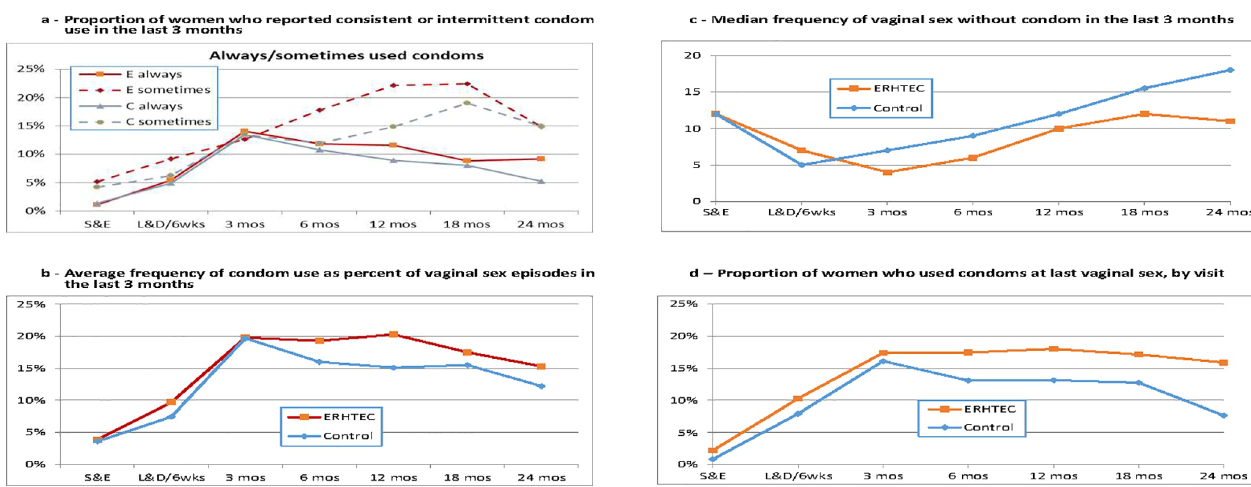
Fig 5. a—Proportion of women who reported consistent or intermittent condom use in the last 3 months, by visit Difference in average change by treatment assignment: p = 0.665 Difference in average follow-up level by treatment assignment: p = 0.056 b—Average frequency of condom use as percent of vaginal sex episodes in the last 3 months Difference in average change by treatment assignment: p = 0.209 Difference in average follow-up level by treatment assignment: p = 0.137 c—Median frequency of vaginal sex without condom in the last 3 months Difference in average change by treatment assignment: p = 0.534 Difference in average follow-up level by treatment assignment: p = 0.148 d—Proportion of women who used condoms at last vaginal sex Difference in average change by treatment assignment: p = 0.353 Difference in average follow-up level by treatment assignment: p =